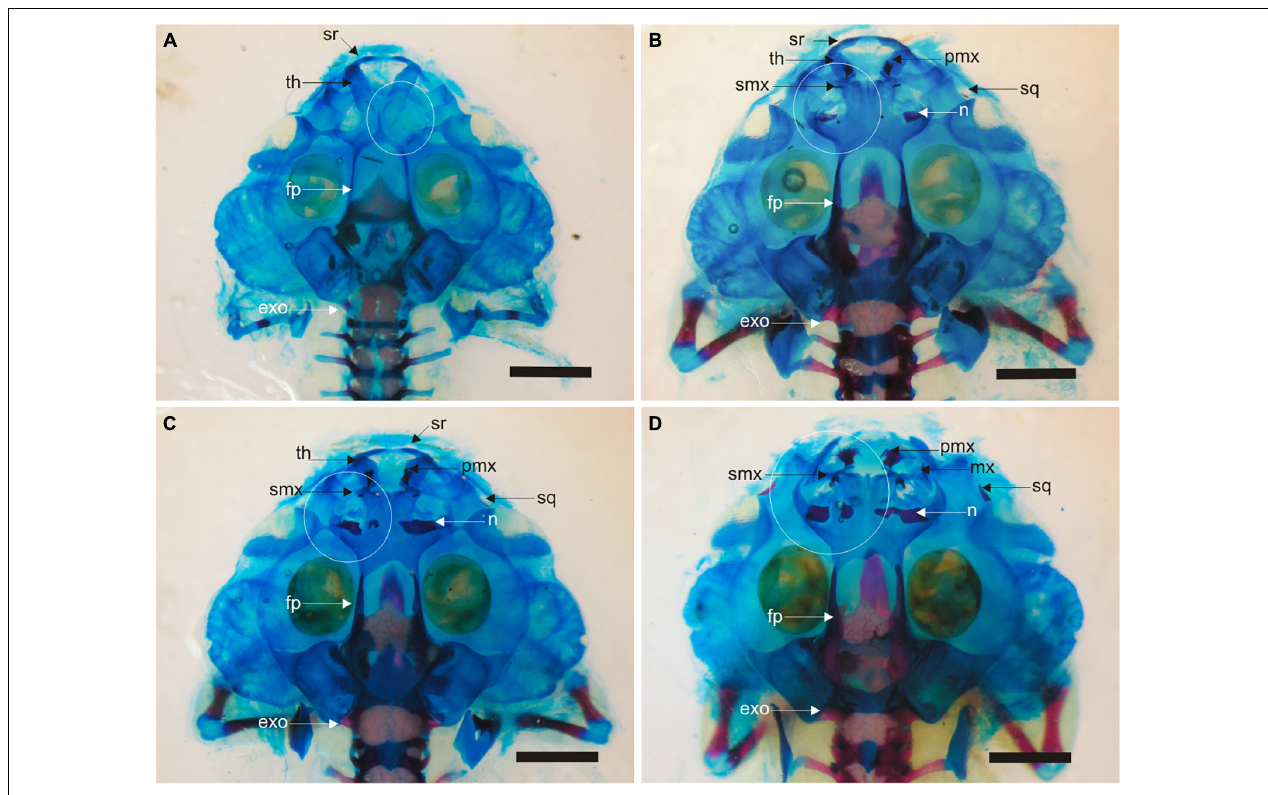
FIGURE 6 | Skull skeleton in tadpoles after 31 days of larval development. (A) Control specimen at Gosner Stage 38. Incipient development of cartilages of olfactory capsule denoted by the white circumference. The ossification of frontoparietals and parasphenoid are already present. Accumulation of calcium is observed in the braincase. (B) Specimen of early exposure to T4 (Gosner Stage 40). Dorsal cartilages of the olfactory region and dermal ossifications (nasals, premaxillae, maxillae, septomaxillae, and squamosals) have differentiated and erosion of trabecular horns has started. Frontoparietals, parasphenoid and exoccipitals are advanced. Accumulation of calcium is observed in the braincase and vertebral column. (C) Specimen of early exposure to methimazole (Gosner Stage 40); same as the specimen described in (B) . (D) Specimen of early exposure to methimazole (Gosner Stage 41). Erosion of larval structures (suprarostral cartilage and trabecular horns) is advanced. exo, exoccipital; fp, frontoparietal; mx, maxillary; n, nasal; pmx, premaxillary; smx, septomaxillary; sq, squamosal; sr, suprarostral; th, trabecular horn. Scale bar is equal 2